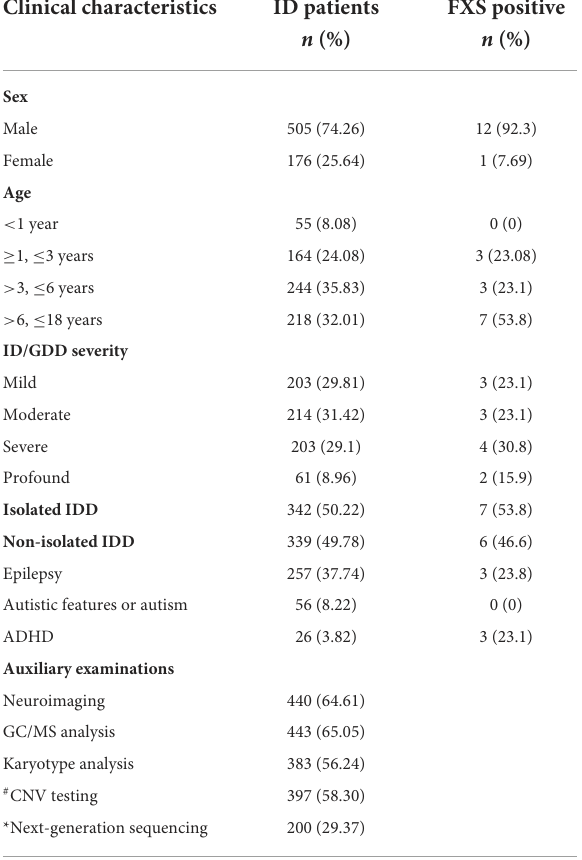
TABLE 1 General information of unexplained etiology ID/GDD individuals ( n = 681). Clinical characteristics